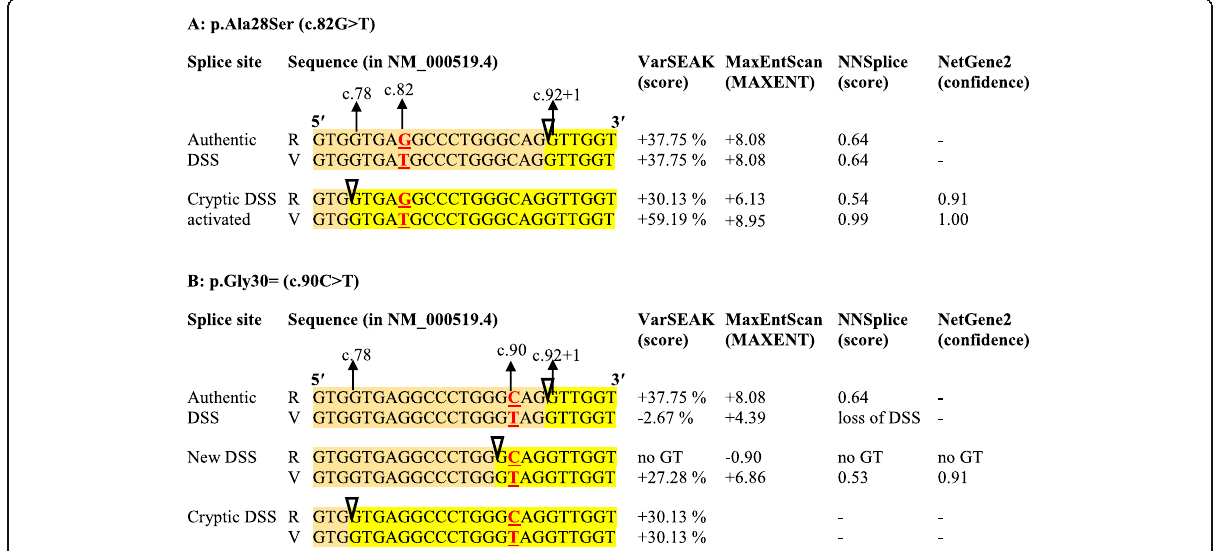
Fig. 2 The predicted splicing effects of p.Ala28Ser ( HBD : c.82G>T) ( a ) and p.Gly30 = ( HBD : c.90C>T) ( b ) variants. The replacement of guanine with thymine at position c.82 activates a cryptic donor splice site (DSS) at c.78. This new splice site is much stronger than the authentic splice site at c.92+1 position ( a ). The replacement of cytosine with thymine at position c.90 decreases the score for the use of authentic DSS at c.92+1 and instead, creates a new DSS at c.89 position or leads to the use of a cryptic splice site located at c.78 ( b ). Gold color means exon sequence; yellow color means intron sequence; triangle means splice